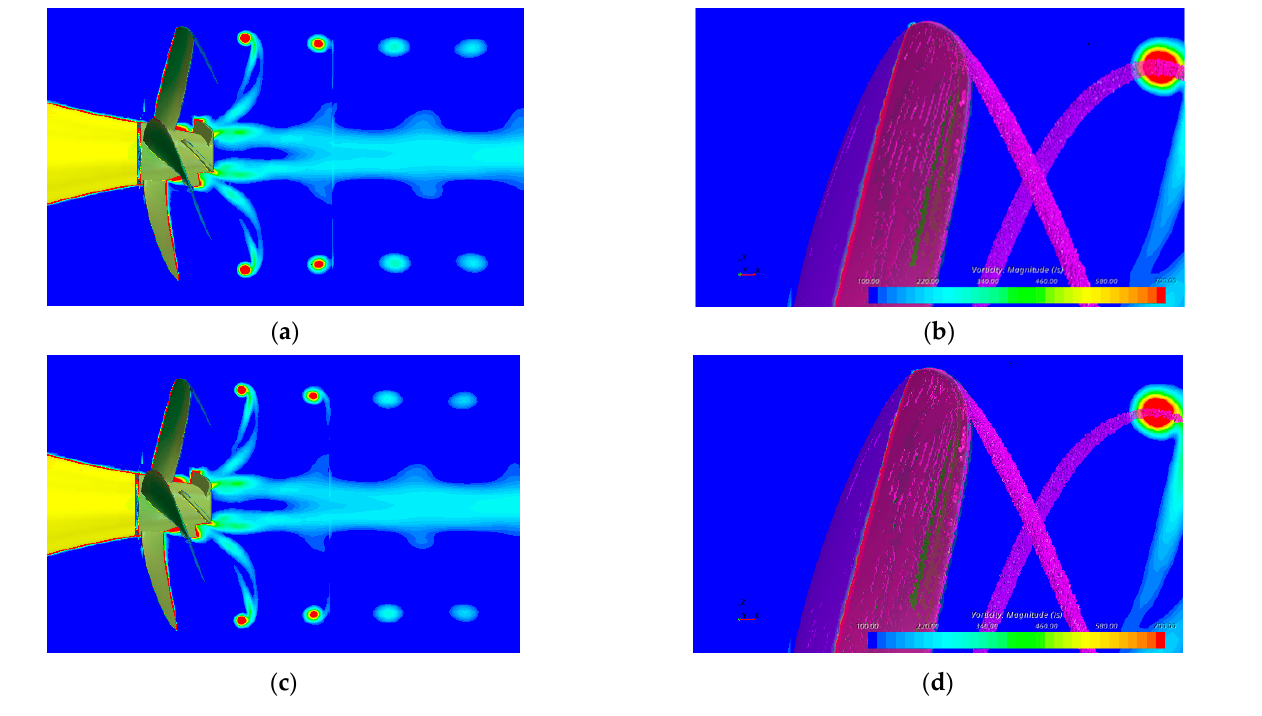
Figure 14. Vorticity contour and iso-surface of Q-Criteria of composite propellers for: ( a , b ) model 1, and ( c , d ) model 5, respectively, in the cavitating flow.